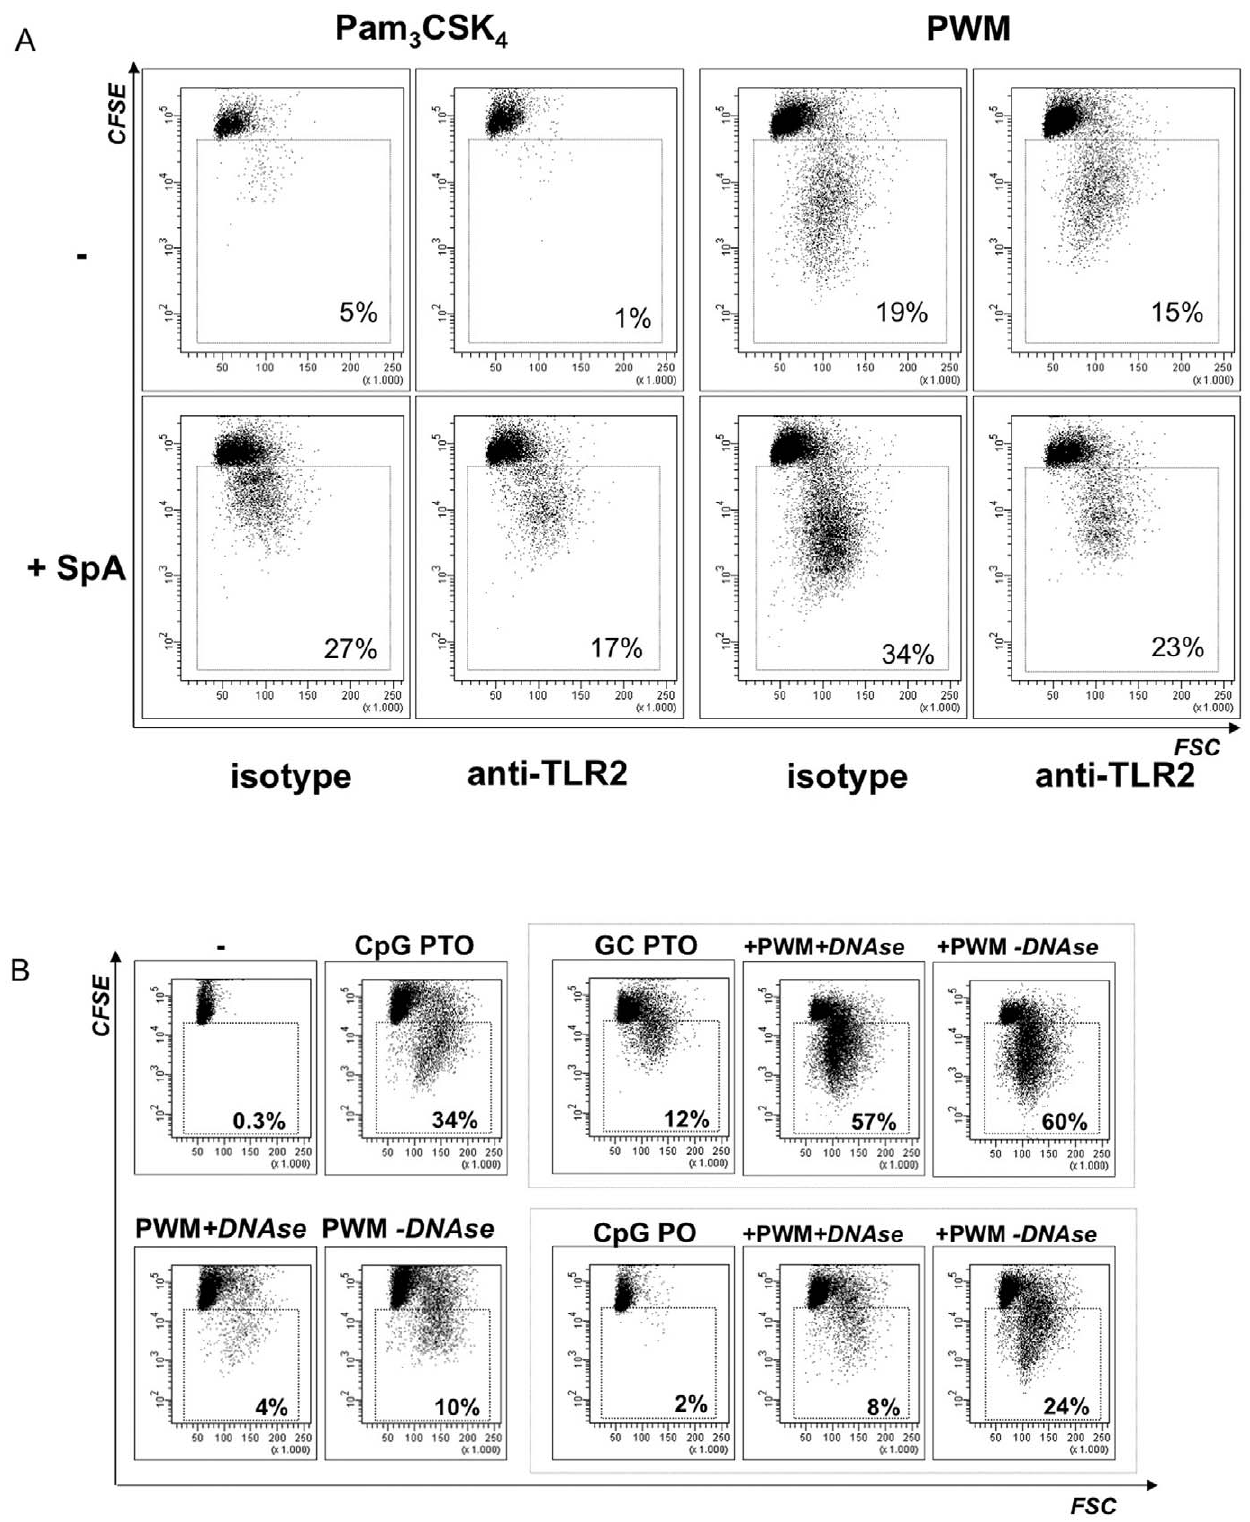
Figure3. Synergistic effects of TLR ligands with poke weedlectin. A: Effect of TLR2 blockageon humanB cell proliferationin response to PWM. CD19 + human peripheral blood B cells were labelled with CFSE, preincubated with anti-TLR2 mAb or the corresponding isotype control (murine IgG 1 k ), and stimulated with Pam 3 CSK 4 or PWM (10 m g/ml) 6 SpA (5 m g/ml) for 5 days. Proliferation was assessed by CFSE dilution. The gate denotesthepercentage of live gated proliferating B cells as depicted. One representativeexperiment of n=3 is shown. B: Synergistic effects of PWM and immunostimulatory DNA. Human B cells were stained with CFSE for assessment of B cell proliferation. Stimulation was performed with CpG ODN 2006 (PTO), DNAse- or mock (reaction buffer only)-treated PWM, 2006 GC (PTO) or CpG 2006 (PO) and combinations thereof as indicated. The graphs show the results from one representative experiment from n $ 3. The percentage of proliferating B cells is indicated in the graphs.